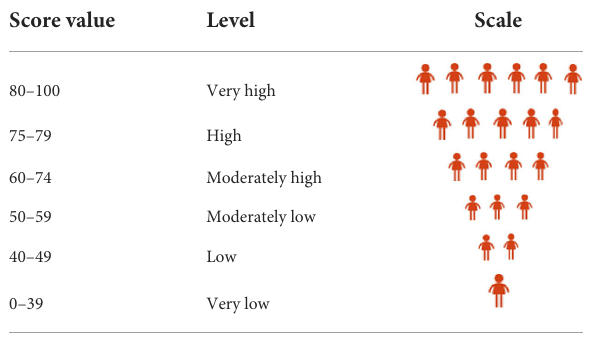
TABLE 1 AQ level interpretation scale of practicum pre-service